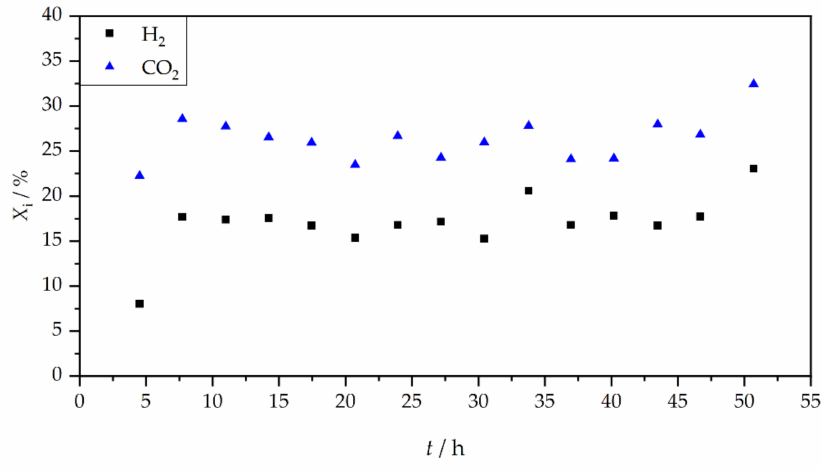
Figure 6. Relative conversion of H 2 and CO 2 for the different intervals during the experimental